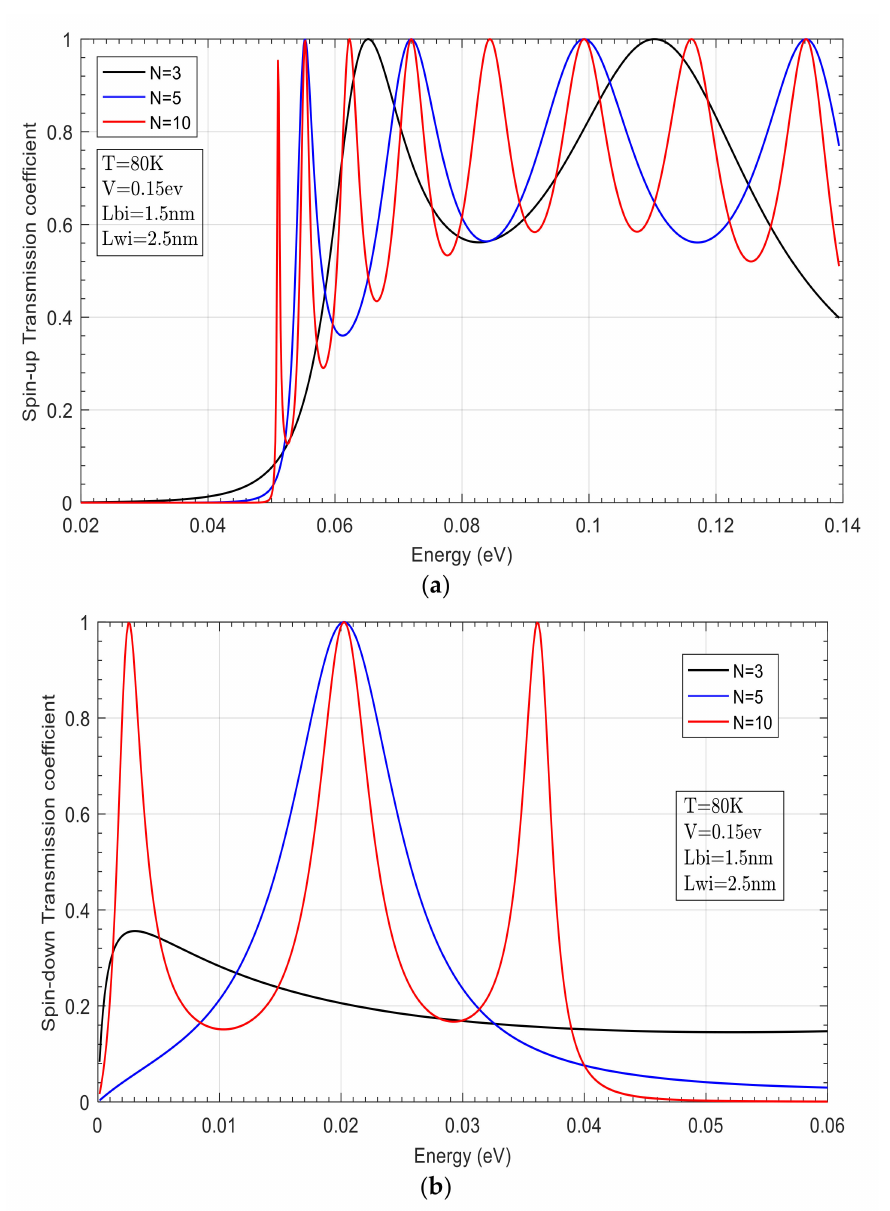
Figure 4. ( a ): The transmission coefficient of spin-up holes as a function of incident energy for three barrier numbers (N = 3, 5, and 10). T = 80 K. ( b ): The transmission coefficient of spin-up holes as a function of incident energy for three barrier numbers (N = 3, 5, and 10). T = 80 K. Finally, the variations of T down (E) and T up (E) as a function of the incident energy for T = 100 K are plotted in Figure 5a, b. By examining these figures, we note two opposite behaviors. For the spin-up holes, the number of oscillations is reduced. However, that of spin-down holes is increased. In other words, T down (E) presents more oscillations for T = 100 K compared to the previous temperatures. For instance, if we examine T down (E) for N = 10, it presents four peaks for T = 100 K, but in the case of T = 80 K, it presents only three resonant states. N = 5 presents only one resonant state for T = 80 K, but it shows two states at T = 100 K. This important result can be used to adjust the desired spin polarization of holes and by selecting the suitable temperature of the